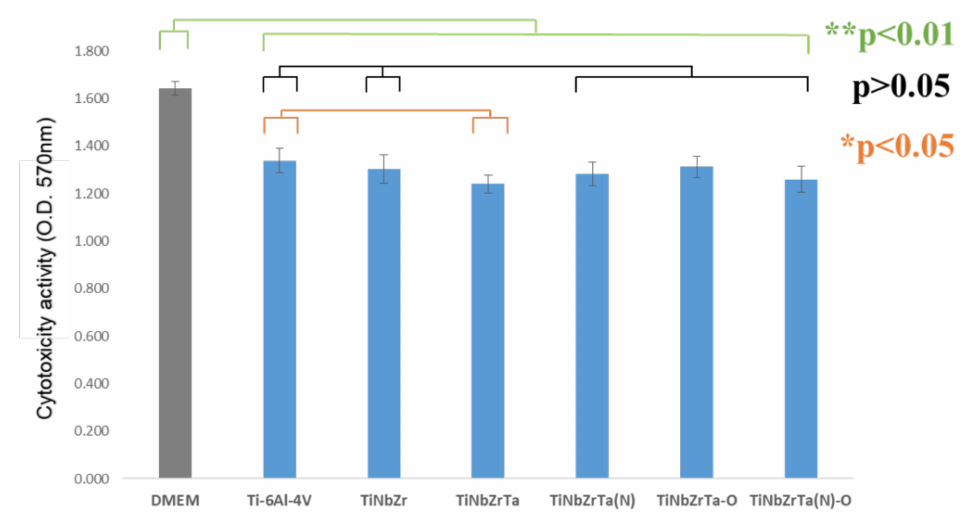
Figure 5. Cytotoxicity analysis of MG-63 cultured on uncoated Ti-6Al-4V and TiNbZrTa series films for 48 h. DMEM acted as the medium with added serum and antibiotics without any coating extraction.